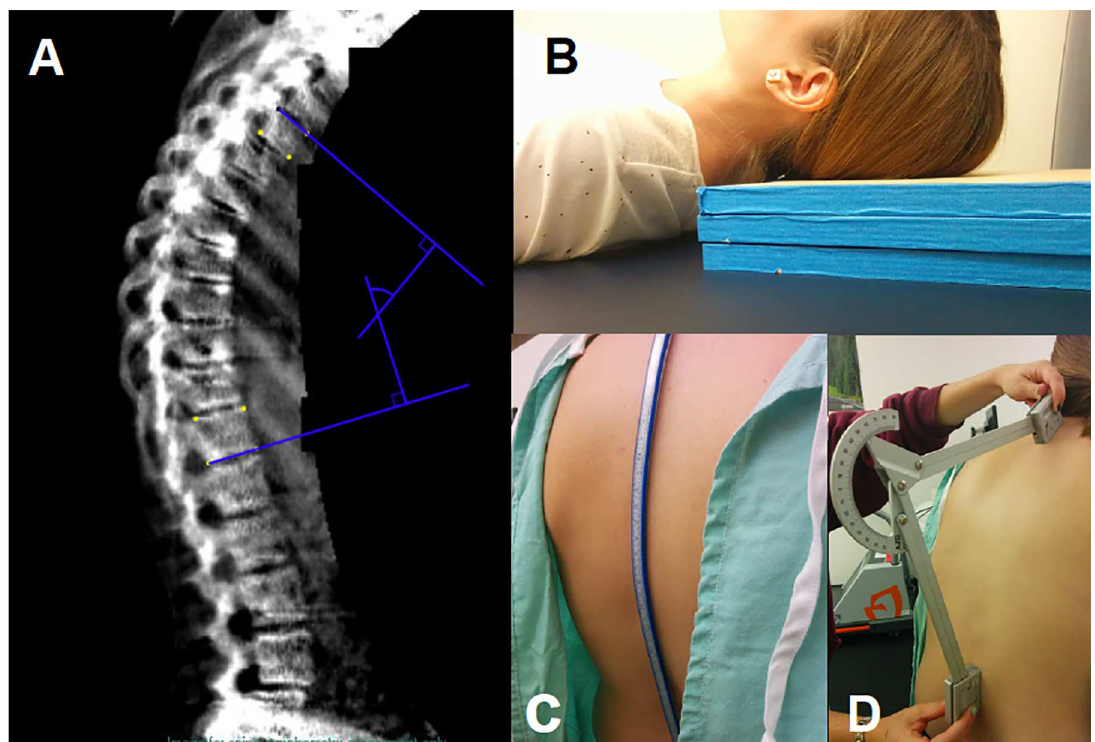
Fig 1. Four measuresof kyphosis. A: Cobb angle measurement. B: Blocks method. C: Architect’s flexicurveruler used to calculatethe kyphotic index. D: Debrunnerkyphometer.